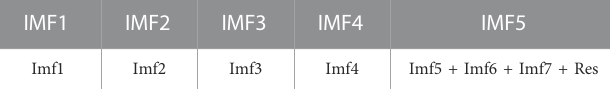
TABLE 6 Recombination of each